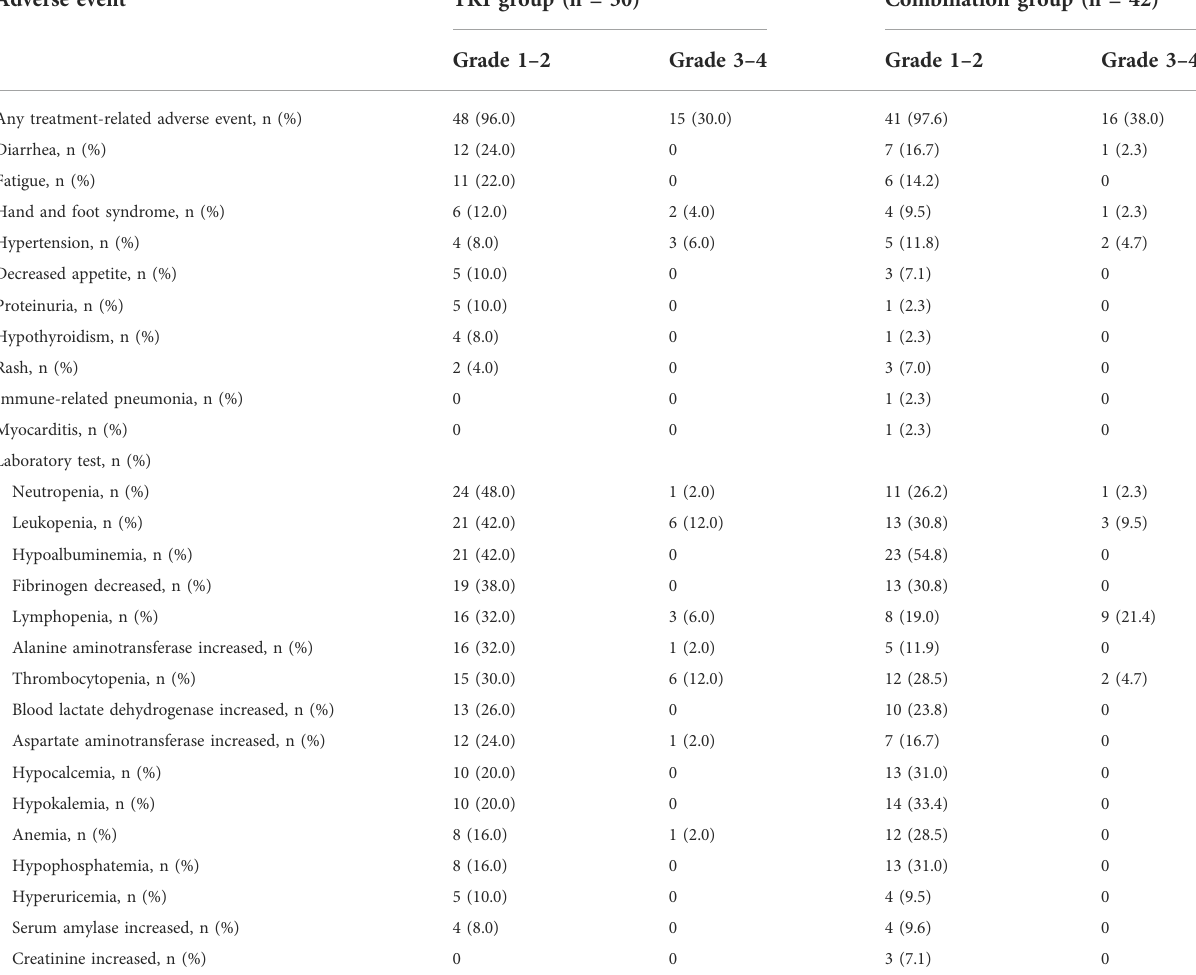
TABLE 4 Treatment-related adverse events